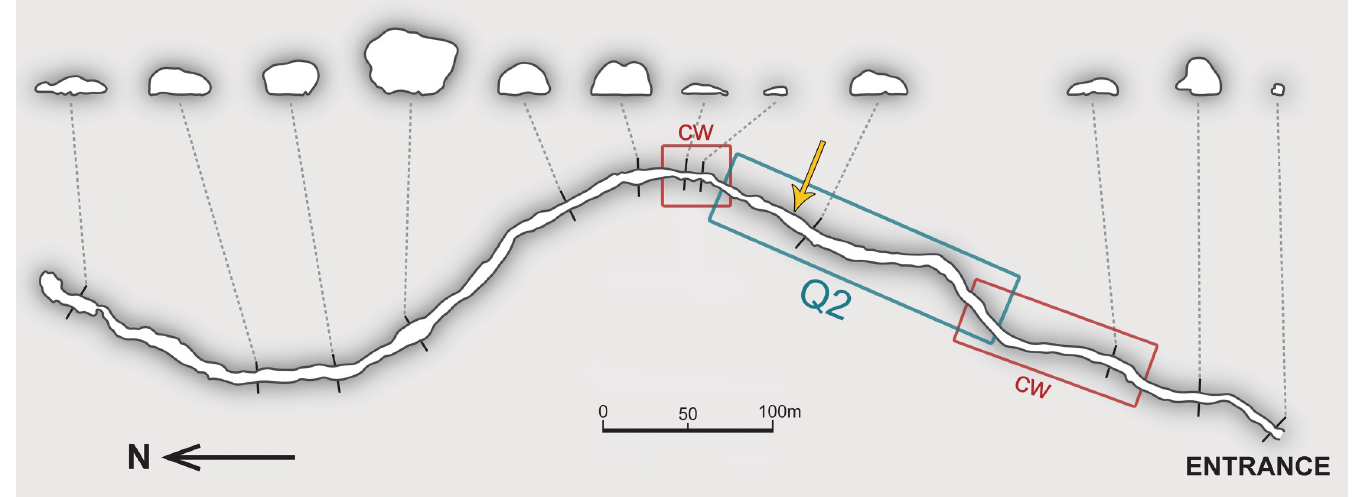
Fig 10. Plan view map of Do ñ a Otilia cave. Transverse sections of the passage are displayed at the same scale. Q2: the humid sector; cw: crawlway passages. Arrow indicates the approximate location of Fig 11A and the collecting site of Otilioleptes marcelae . Redrawn from a 1973 survey made by C.A.E. (Centro Argentino de